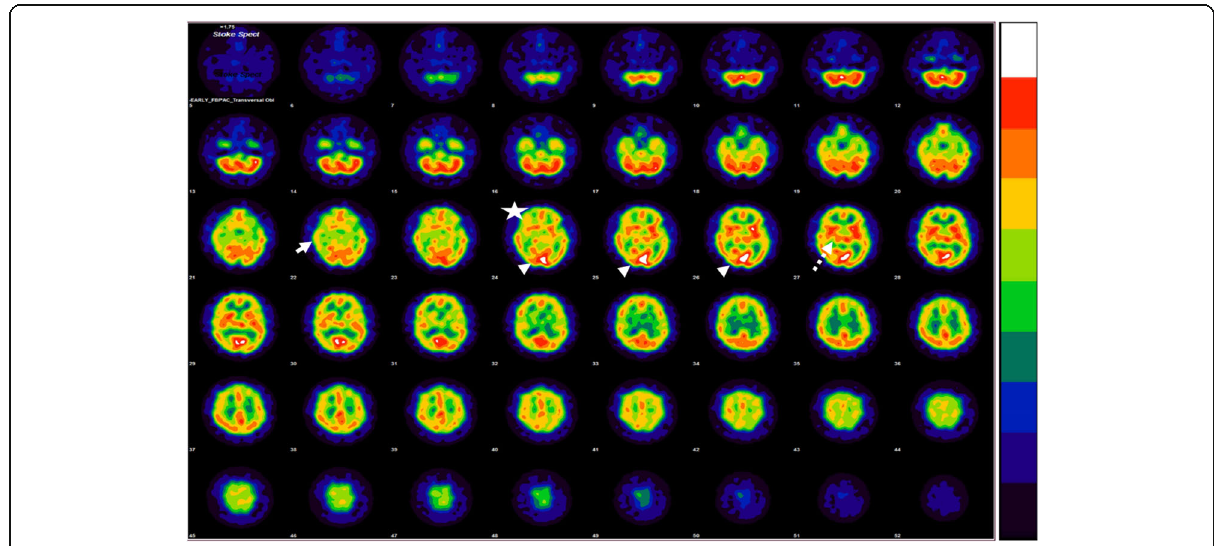
Fig. 1 Axial single photon emission computer tomography with Tc-99 m ECD shows hypoperfusion to the right cerebral hemisphereinvolving right inferior frontal (star),temporal (white arrow), occipital regions (arrow head) and right thalamus (dashed